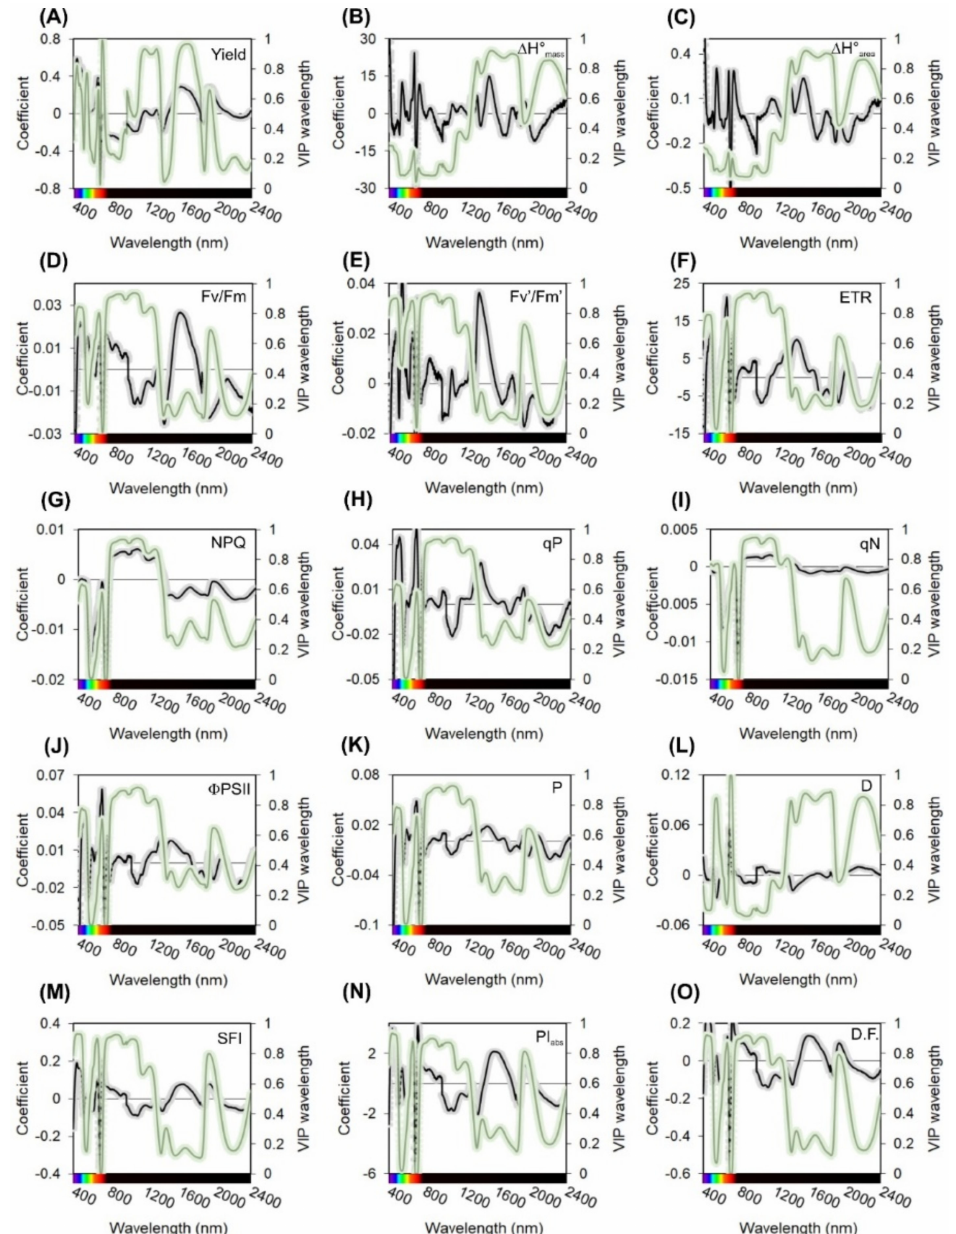
Figure 4. Mean and standard error of regression coefficients (RCs) and variable importance to the projection (VIP) methods. ( A ) Yield, biomass of tobacco plants (g plant − 1 ); ( B ) ∆ H ◦ mass (kcal g − 1 ), calorimeter energy content by mass; ( C ) ∆ H ◦ area (kcal m − 2 ), calorimeter energy content by area; ( D ) Fv/Fm: Maximum quantum efficiency of PSII photochemistry in the dark-acclimated state; ( E ) Fv’/Fm’: Maximum efficiency of PSII in light-acclimated state; ( F ) ETR, electron transport rate ( µ mol m − 2 s − 1 ); ( G ) NPQ, non-photochemical quenching calculated as (Fm − Fm’)/Fm’; ( H ) qP: Photochemical quenching calculated as (Fm’ − Fs)/(Fm’ − Fo’); ( I ) qN: Non-photochemical quench- ing calculated as (Fm − Fm’)/(Fm − Fo’); ( J ) Φ PSII, PSII operating efficiency in light conditions as calculated (1 − Fs/Fm’); ( K ) P, the fraction of light absorbed in PSII antennae that is utilized in PSII photochemistry; ( L ) D, fraction of light absorbed in PSII antennae that is dissipated thermally; ( M ) SFI, Structure function index; ( N ) PI (abs) , Performance index for energy conservation from photons ab- sorbed by PSII antenna, until the reduction of PSI acceptors; ( O ) D.F., Driving force on absorption light by cross-section